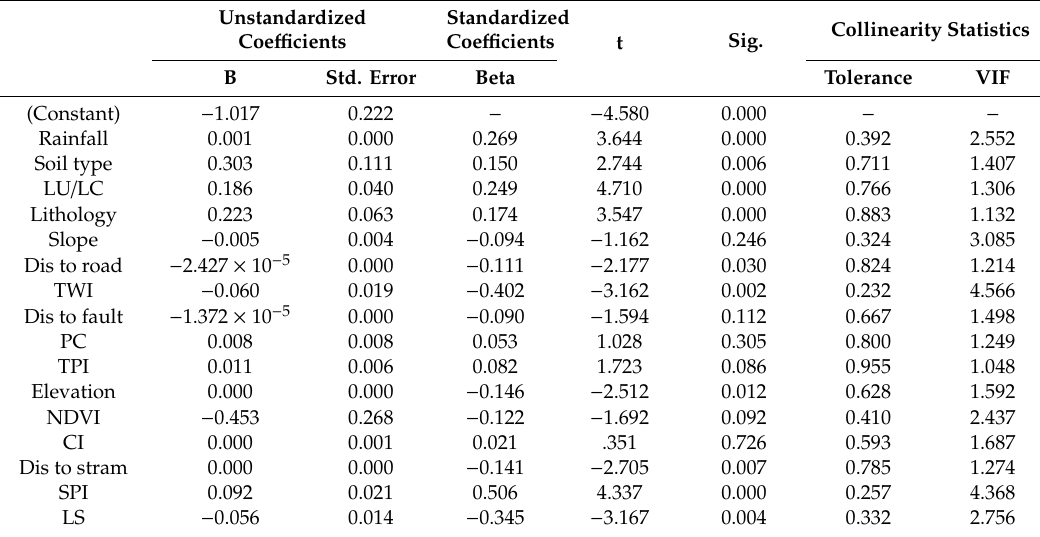
Table 2. Multi-collinearity analysis among landslide conditioning